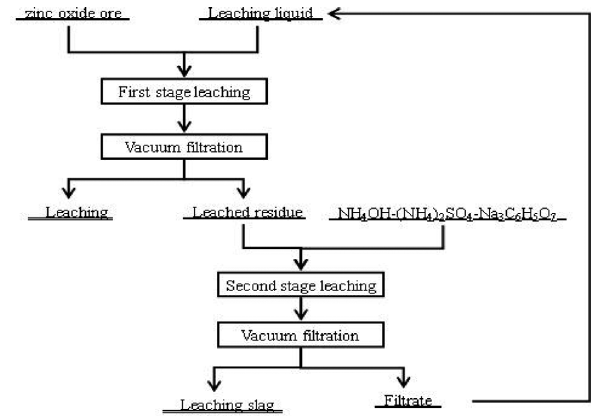
Figure 4: Flow diagram of low-grade oxide zinc ores leaching.